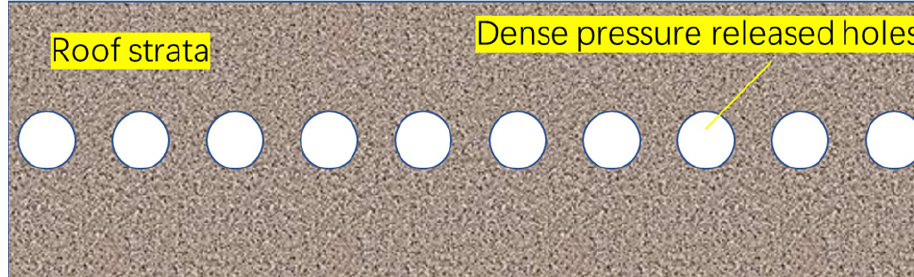
Figure 10. Layout of dense pressure-released holes.